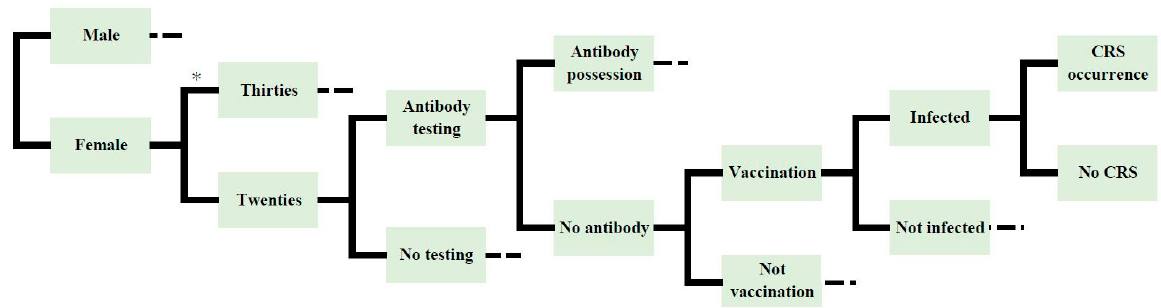
Figure 1. Decision tree model of the vaccination method.